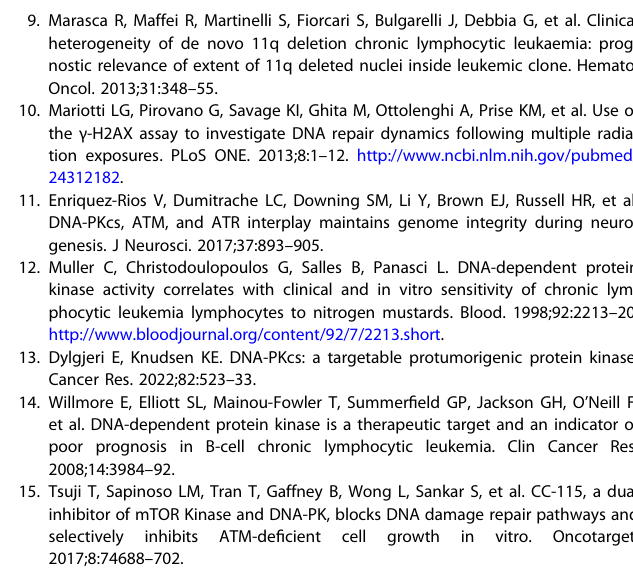
Fig. 2 NU7441 is cytotoxic to CLL cells, but not normal B/T cells, and sensitizes CLL patient cells to chemotherapy. Primary CLL cells or PBMCs from non-CLL donors were treated with chlorambucil (CLB) or ibrutinib (IBR) for ~72 h alone or in the presence of 1 μ M NU7441 (NU) in SFM, or co-treated with CD40L/IL4 or IgM and viability was measured by fl ow cytometry. A While CLL cell viability is reduced by NU7441, normal B (CD19 + ) and T (CD3 + ) cells are not. B Both del 11q and non-del 11q CLL cells treated with chlorambucil result in multi-fold lower EC 50 values when co-treated with NU7441, while ( C ) EC 50 values of ibrutinib are not affected by NU7441 co-treatment. Plots represent median ± interquartile range and p values were calculated using a paired t -test or a Mann – Whitney test. DNA-PK inhibition is synergistic with chlorambucil, even in CLL cells from patients on developing resistance to ibrutinib. D Combene fi t synergy plots from CLL samples from patients who were treatment (Tx) naïve or on long-term ibrutinib treated ex vivo for ~72 h with combinations of chlorambucil or ibrutinib with M3814 in SFM, demonstrating marked synergy between M3814 and chlorambucil but not ibrutinib, even in patients who were receiving ibrutinib or were resistant to ibrutinib. Plots represent the degree of synergy (blue), additivity (green), or antagonism (red). Changes in DNA- PK and ATM activation are inversely correlated while CLL patients are on long-term ibrutinib. E Western blot of CLL cells taken prior to and while on long-term ibrutinib. pDNA-PK:DNA-PK levels increase in most patients while on long-term ibrutinib, pATM:ATM levels decrease in some patients and pBTK:BTK is eliminated by ibrutinib. DNA-PK inhibition is synergistic with chlorambucil, but not ibrutinib, in CLL patient cells following long-term ibrutinib treatment or resistance. F EC 50 of chlorambucil and ibrutinib determined by fl ow cytometry (from 2D) following ~72 h treatment alone or with 1 μ M NU7441 or 250 nM M3814 before or during clinical treatment of the patient, showing sensitization of cells to chlorambucil but not ibrutinib even when patients were receiving chlorambucil (1020), ibrutinib (733, 1440, 190,